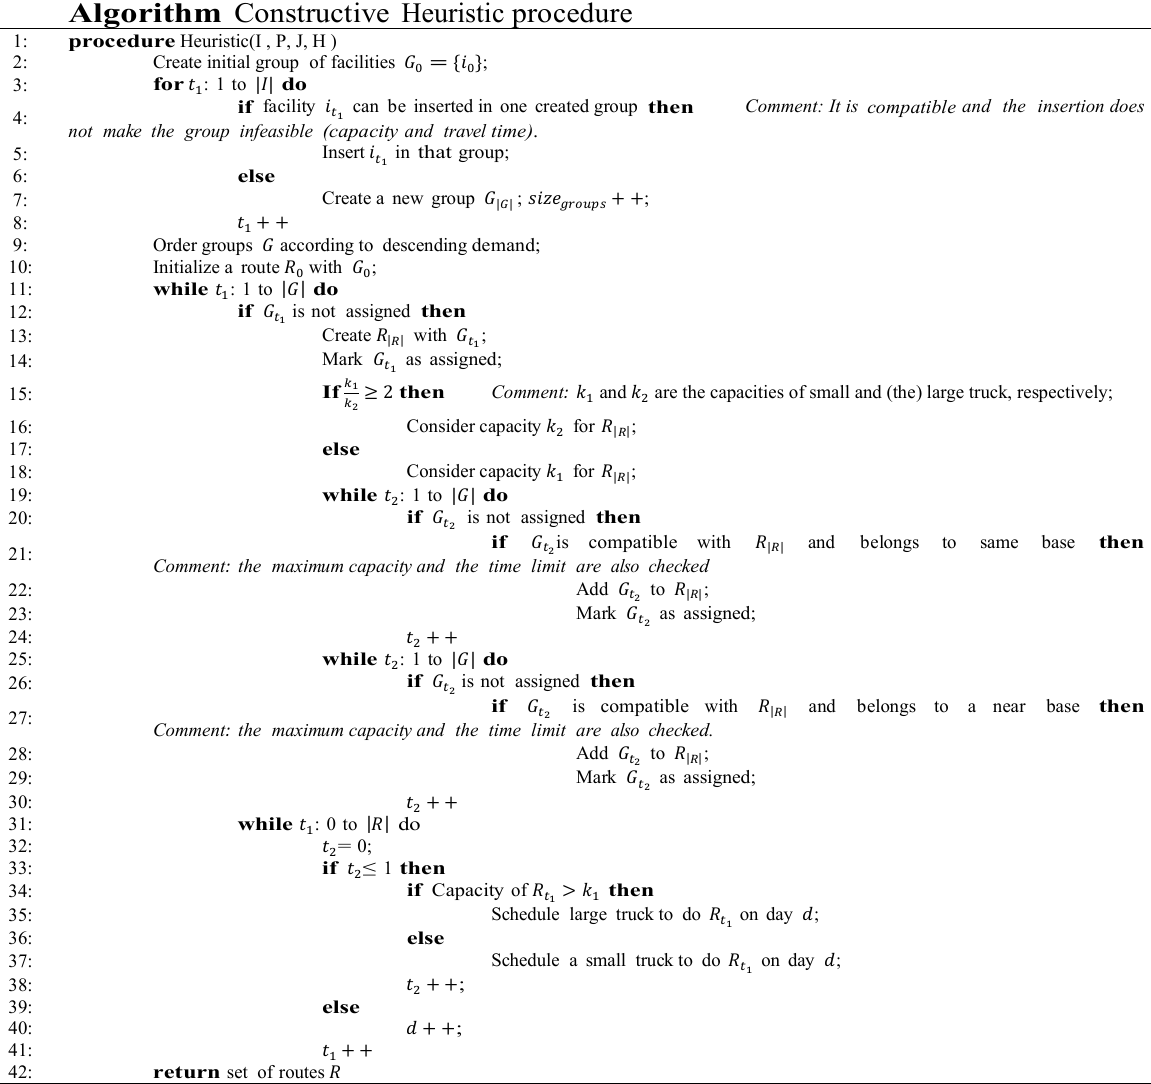
Algorithm Constructive Heuristic